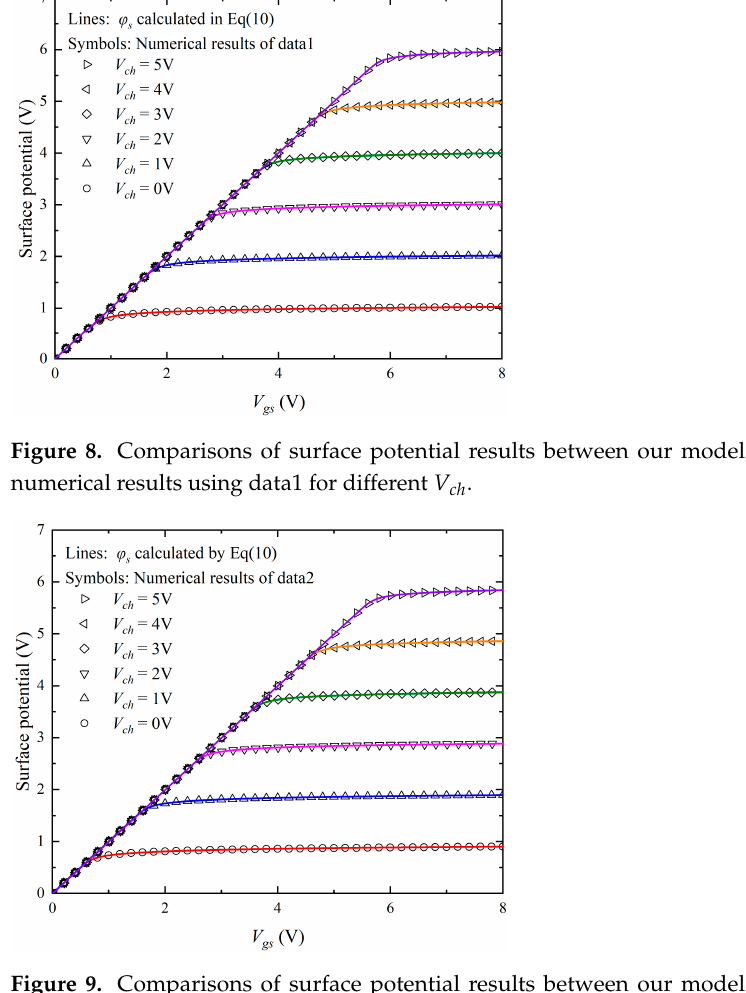
Figure 9. Comparisons of surface potential results between our model, regional approach and numerical results using data2 for different V ch .